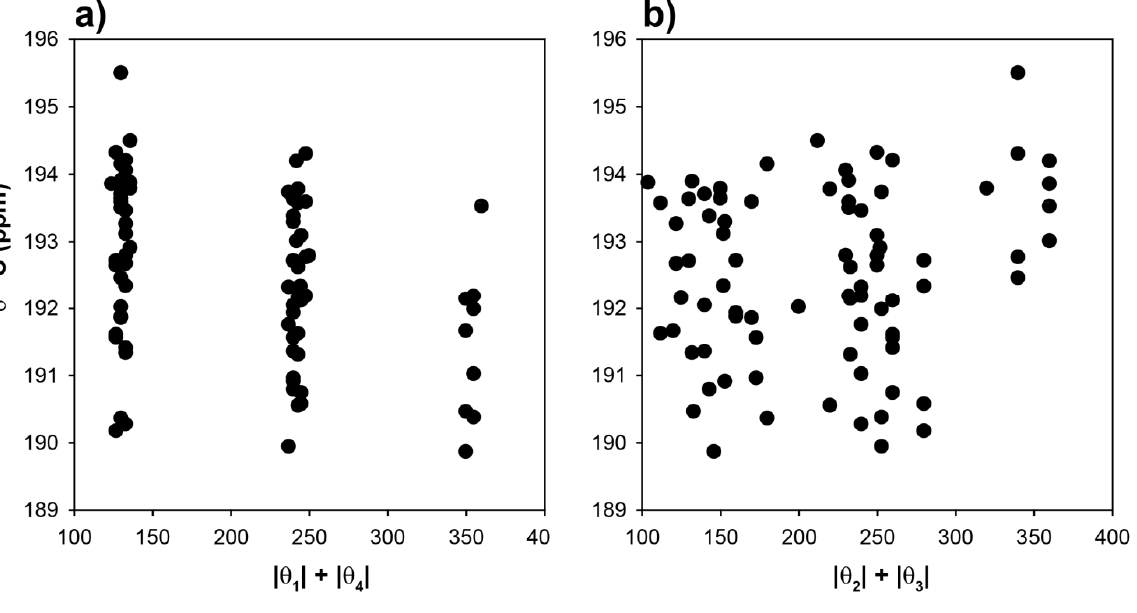
+ | θ | dihedral angle summation and, ( b ) the | θ | 1 4